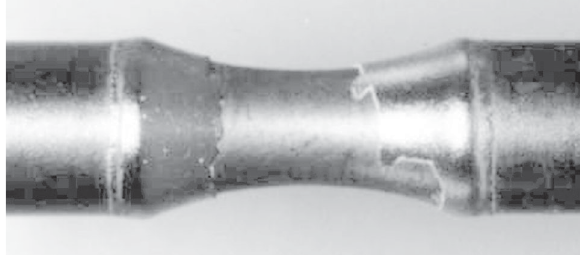
Figure 3. Delamination of the electroless nickel layer/base metal shot peened